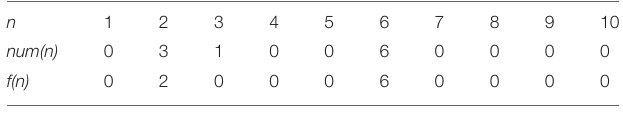
TABLE 2 | Fitness evaluation of the trait set in Table 1